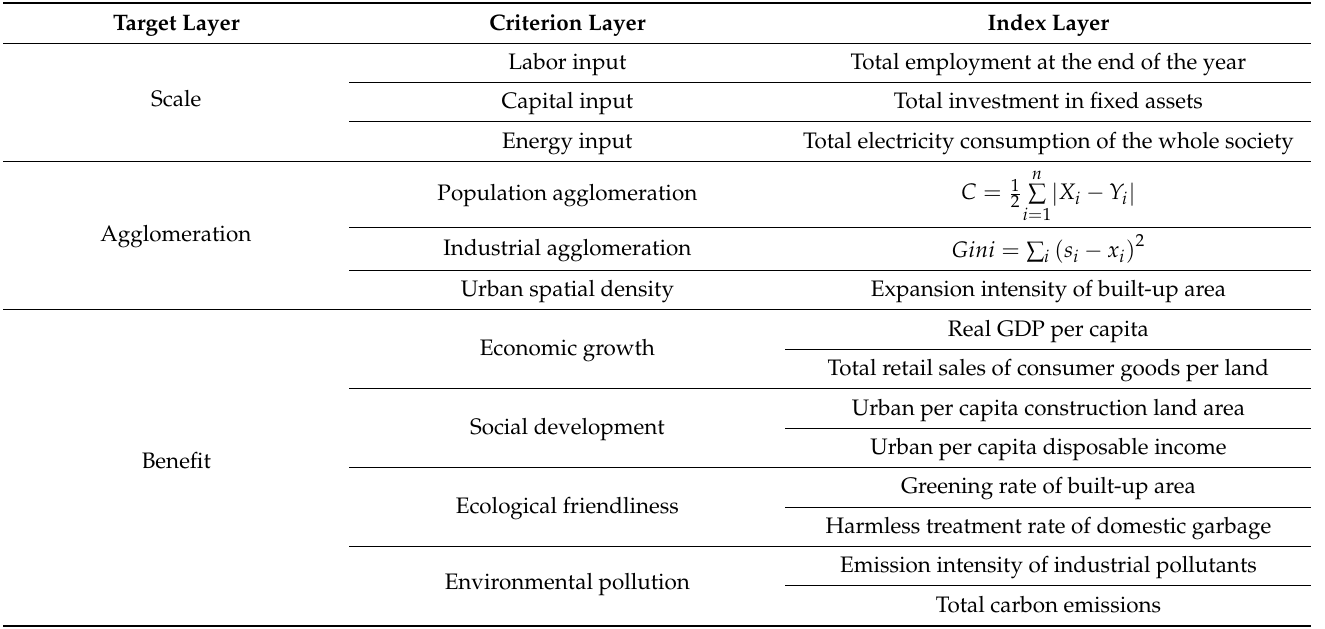
Table 1. Indicators system of